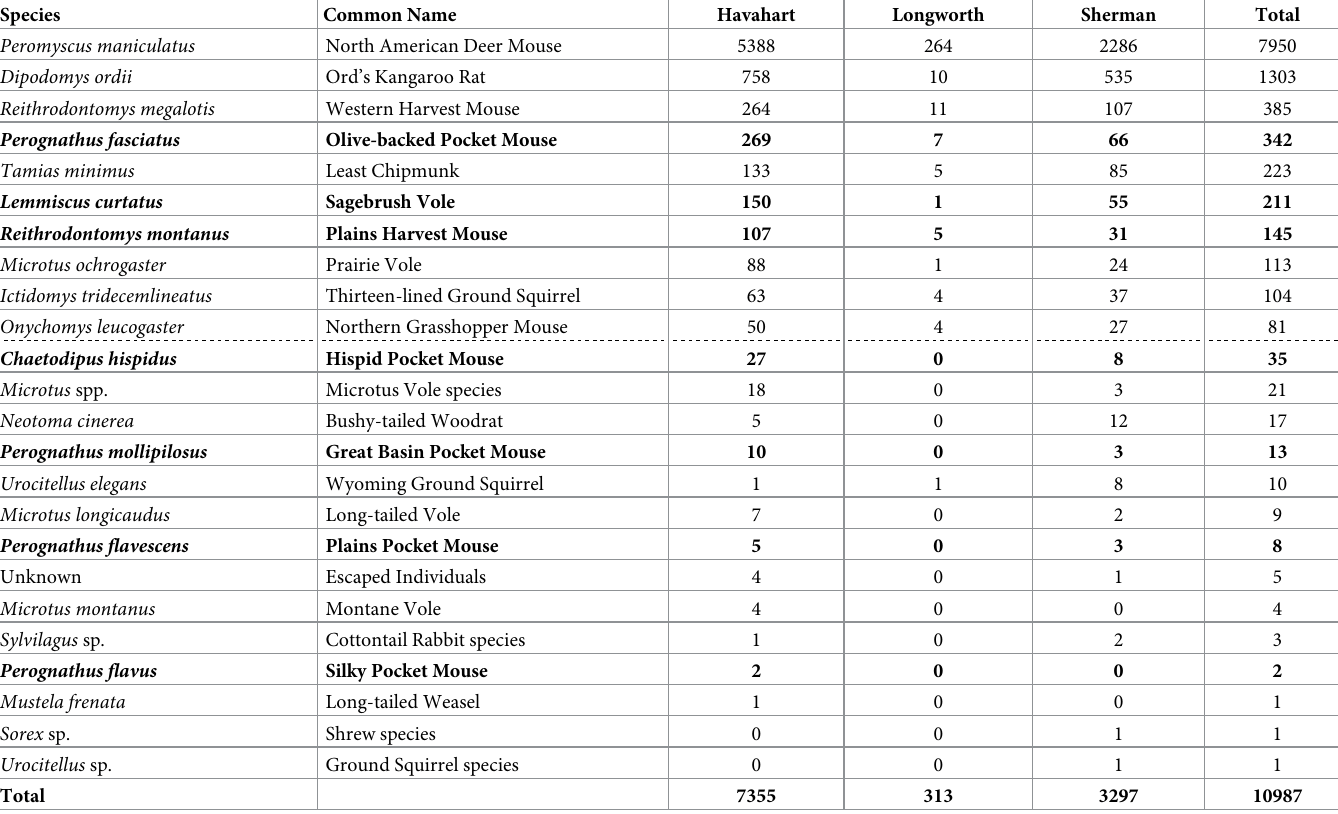
Table 1. The number of captures within each species in each trap